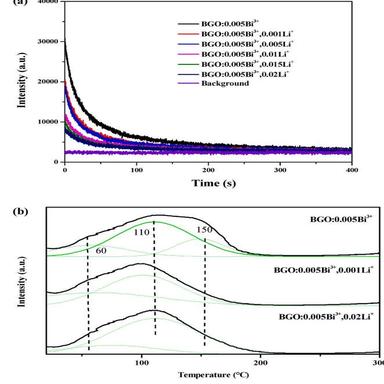
(a) NIR persistent luminescence decay curves for BGO: 0.005Bi3+,yLi+ (monitored at 710 nm after 254 nm UV light illumination for 5 min), (b) thermoluminescence (TL) curves of BGO:0.005Bi3+, yLi+(y = 0,0.001,0.02).